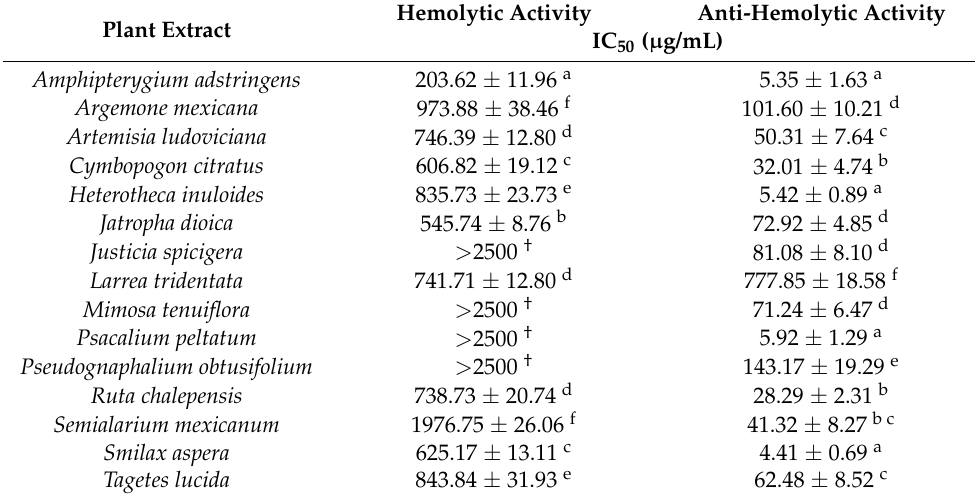
Table 4. Hemolytic and anti-hemolytic activities of Mexican plant extracts on human erythrocytes. Hemolytic Activity Anti-Hemolytic Activity Plant Extract IC 50 ( µ g/mL)